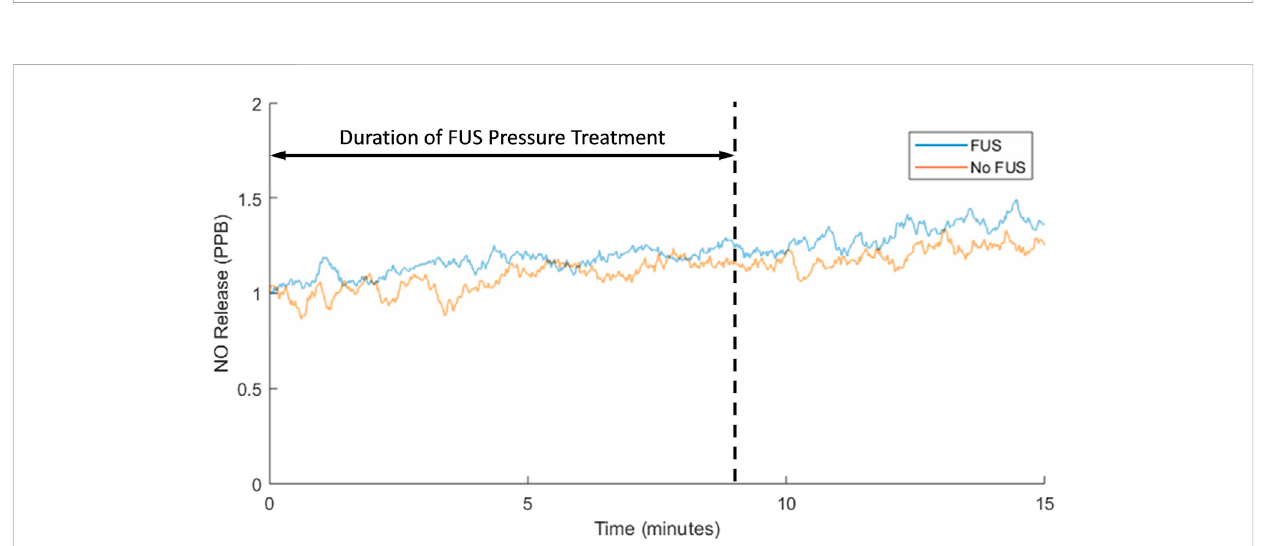
FIGURE 14 NO release from 4.8 mg SNAP- fi brin particles in composite hydrogels treated with FUS pressure stimulus (±3 MPa) at a 10% duty cycle for 9.5 min.